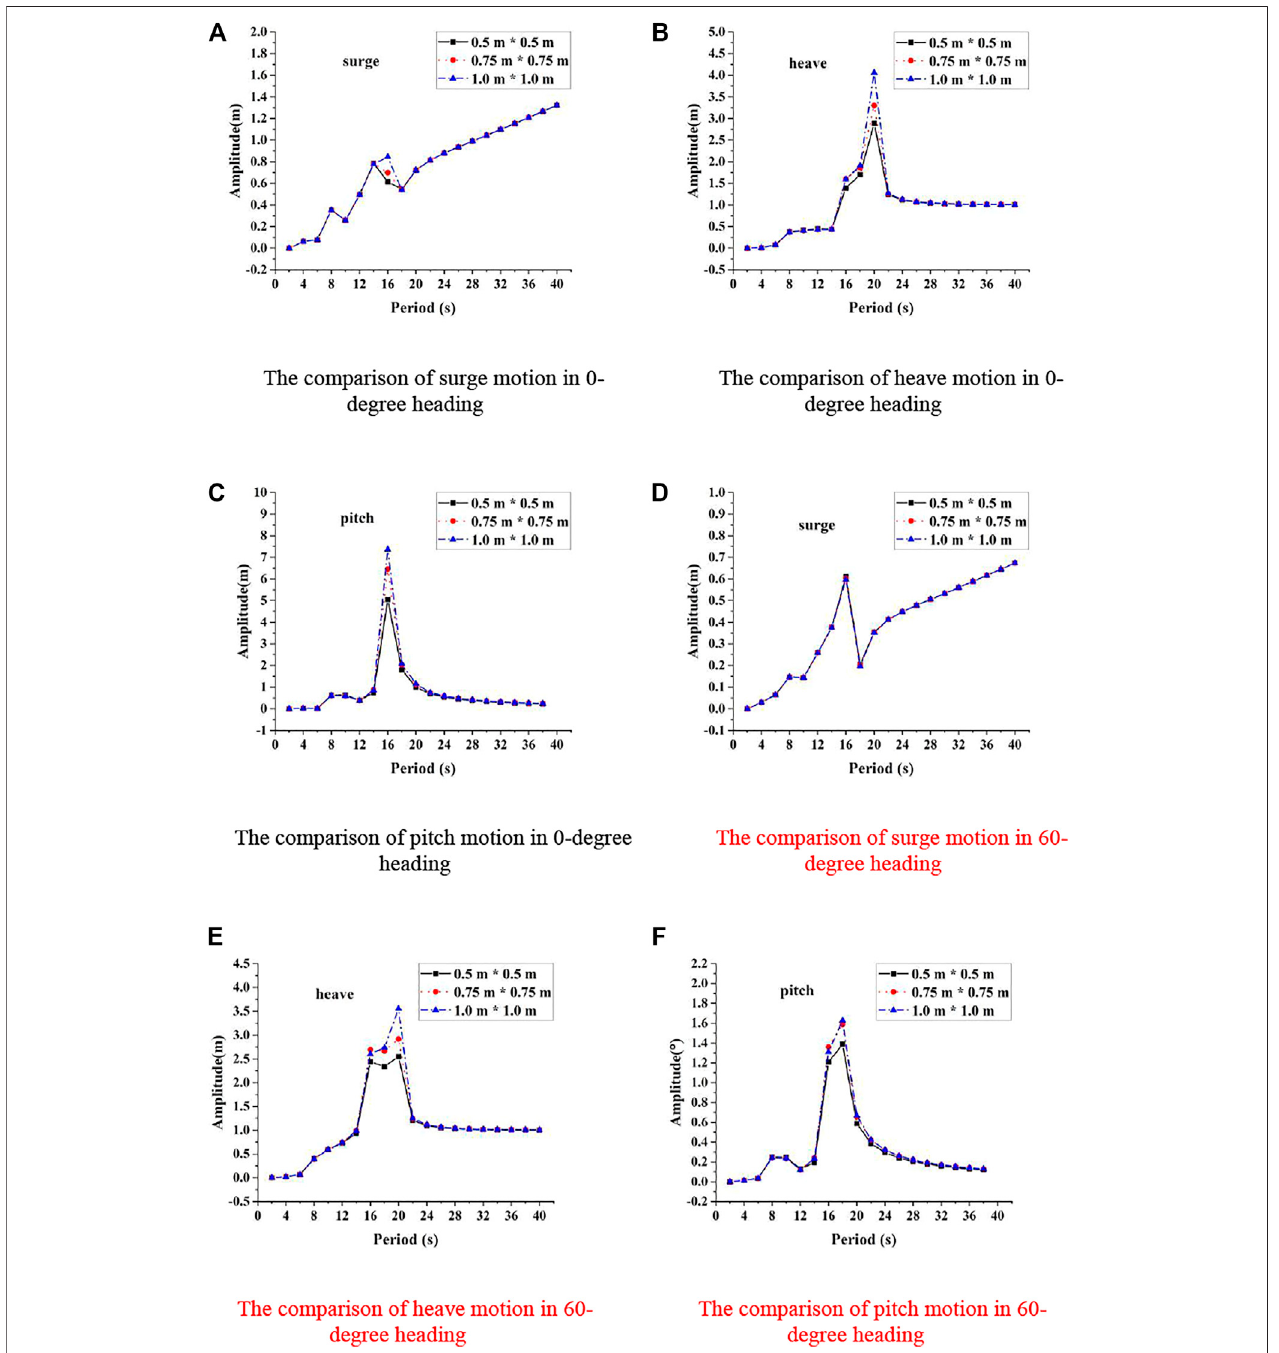
FIGURE4 | Comparison ofthe motion responsesof three kinds of mesh models in the frequency domain with 0-degree and 60-degreeincoming wave directions. (A) Comparison of surge motion in 0-degree heading. (B) Comparison of heave motion in 0-degree heading. (C) Comparison of pitch motion in 0-degree heading. (D) Comparison of surge motion in 60-degree heading. (E) Comparison of heave motion in 60-degree heading. (F) Comparison of pitch motion in 60-degree